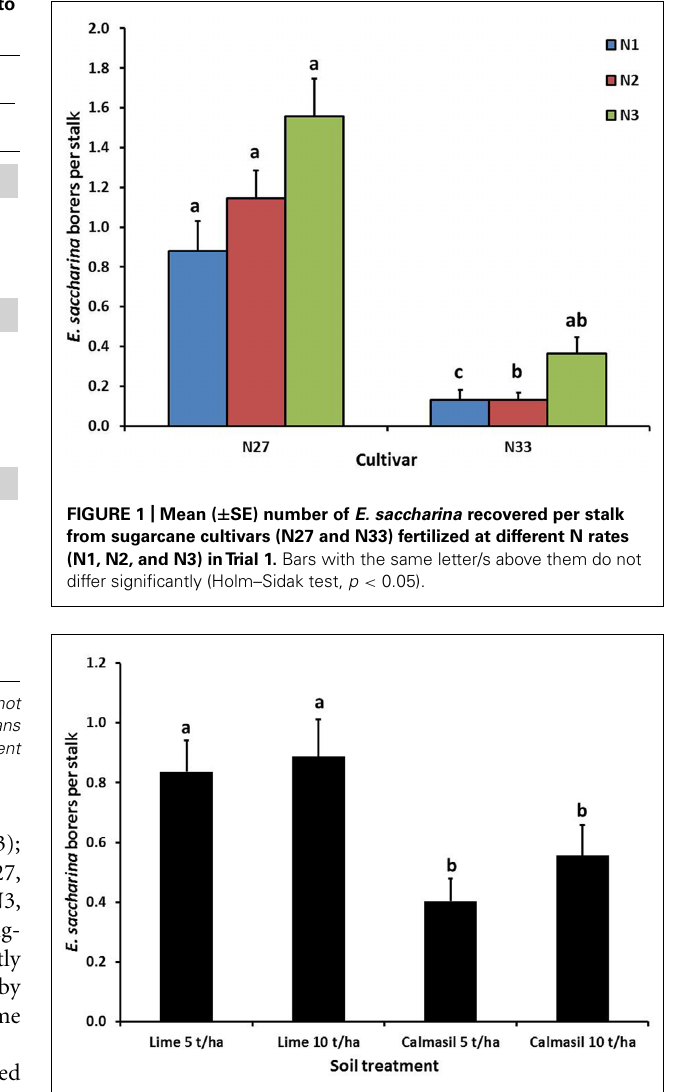
FIGURE 2 | Mean ( ± SE) number of E. saccharina recovered per stalk from sugarcane amended with Calmasil and lime at two different rates inTrial 1. Bars with the same letter/s above them do not differ significantly (Holm–Sidak test, p <